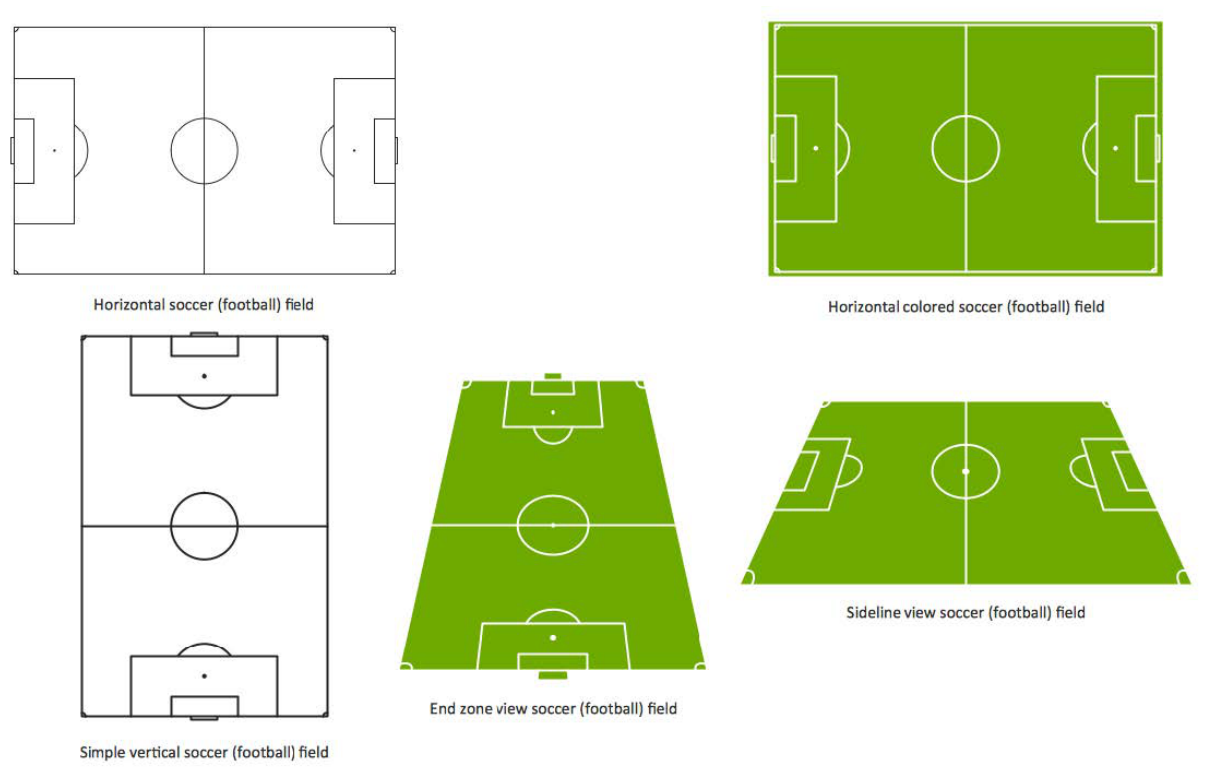
Fig. 1 Division of football match